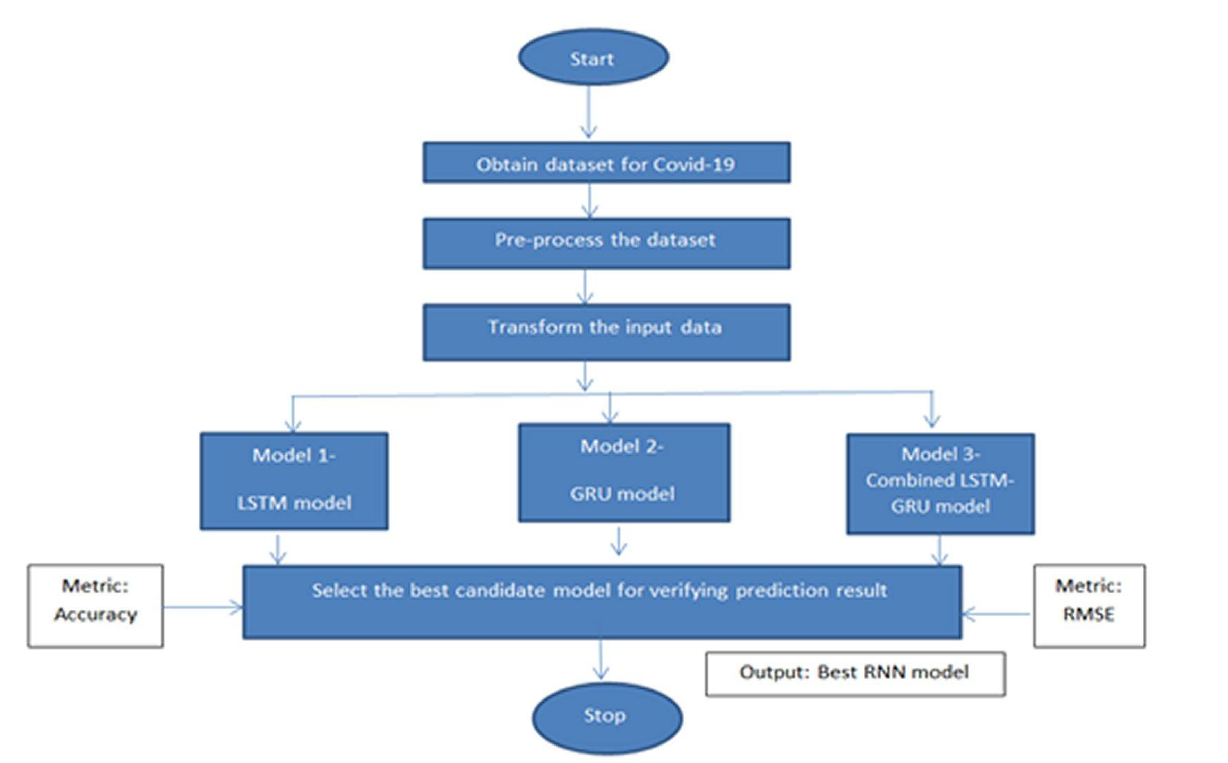
Figure 1: Diagrammatic Approach for the workflow of proposed